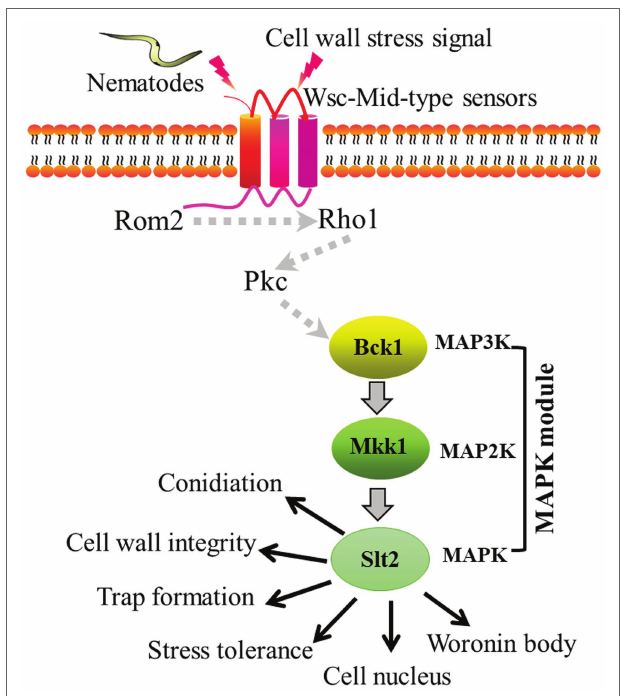
FIGURE 7 | Proposed model for the regulation of AoBck1 and AoMkk1 in Arthrobotrys oligospora . Arthrobotrys oligospora senses nematode or cell wall stress signals and transmits them into the cells to activate Rho1 and Pkc, then triggers the cell wall integrity (CWI)-MAPK cascade and initiates various regulatory pathways, thereby regulating various a series of biological processes. The dashed arrows indicate the putative connections; the solid arrow indicates the experimental